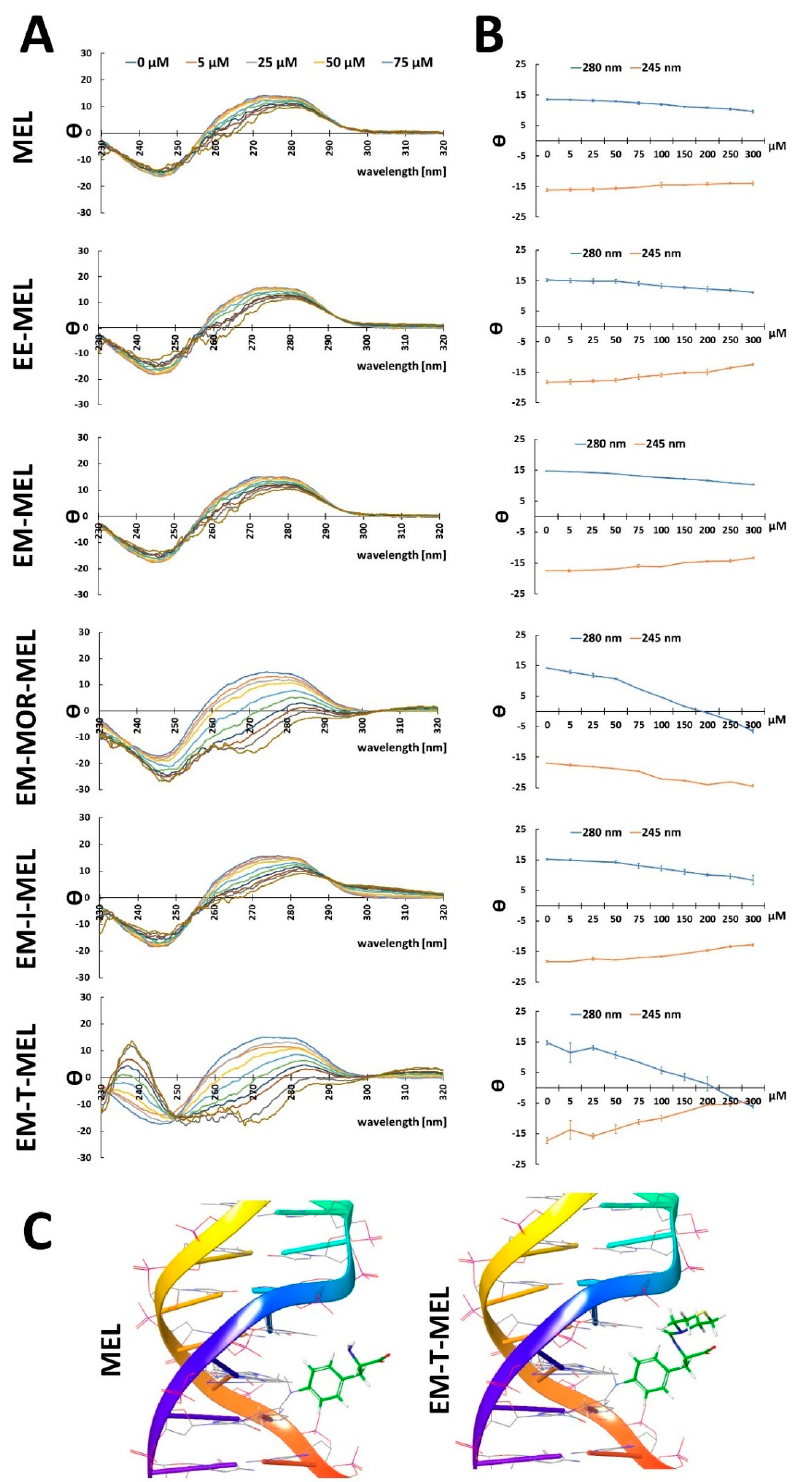
Figure 1. Chemical modifications of the melphalan molecule affect the B-DNA structure. ( A ) The CD spectra of DNA in the presence of MEL, EE-MEL, EM-MEL, EM-MOR-MEL, EM-I-MEL, and EM-T-MEL. ( B ) Changes in θ / θ 0 parameter at λ = 245 nm and λ = 280 nm in the presence of MEL, EE-MEL, EM-MEL, EM-MOR-MEL, EM-I-MEL, and EM-T-MEL. Results are the mean ± standard deviation (SD), n = 3. ( C ) Visualizations showing the binding site to DNA of the original drug MEL and the most potent derivative EM-T-MEL. The visualizations were created in PyMOL (Schrödinger, Inc.). Computer simulation was performed for one DNA molecule and one ligand